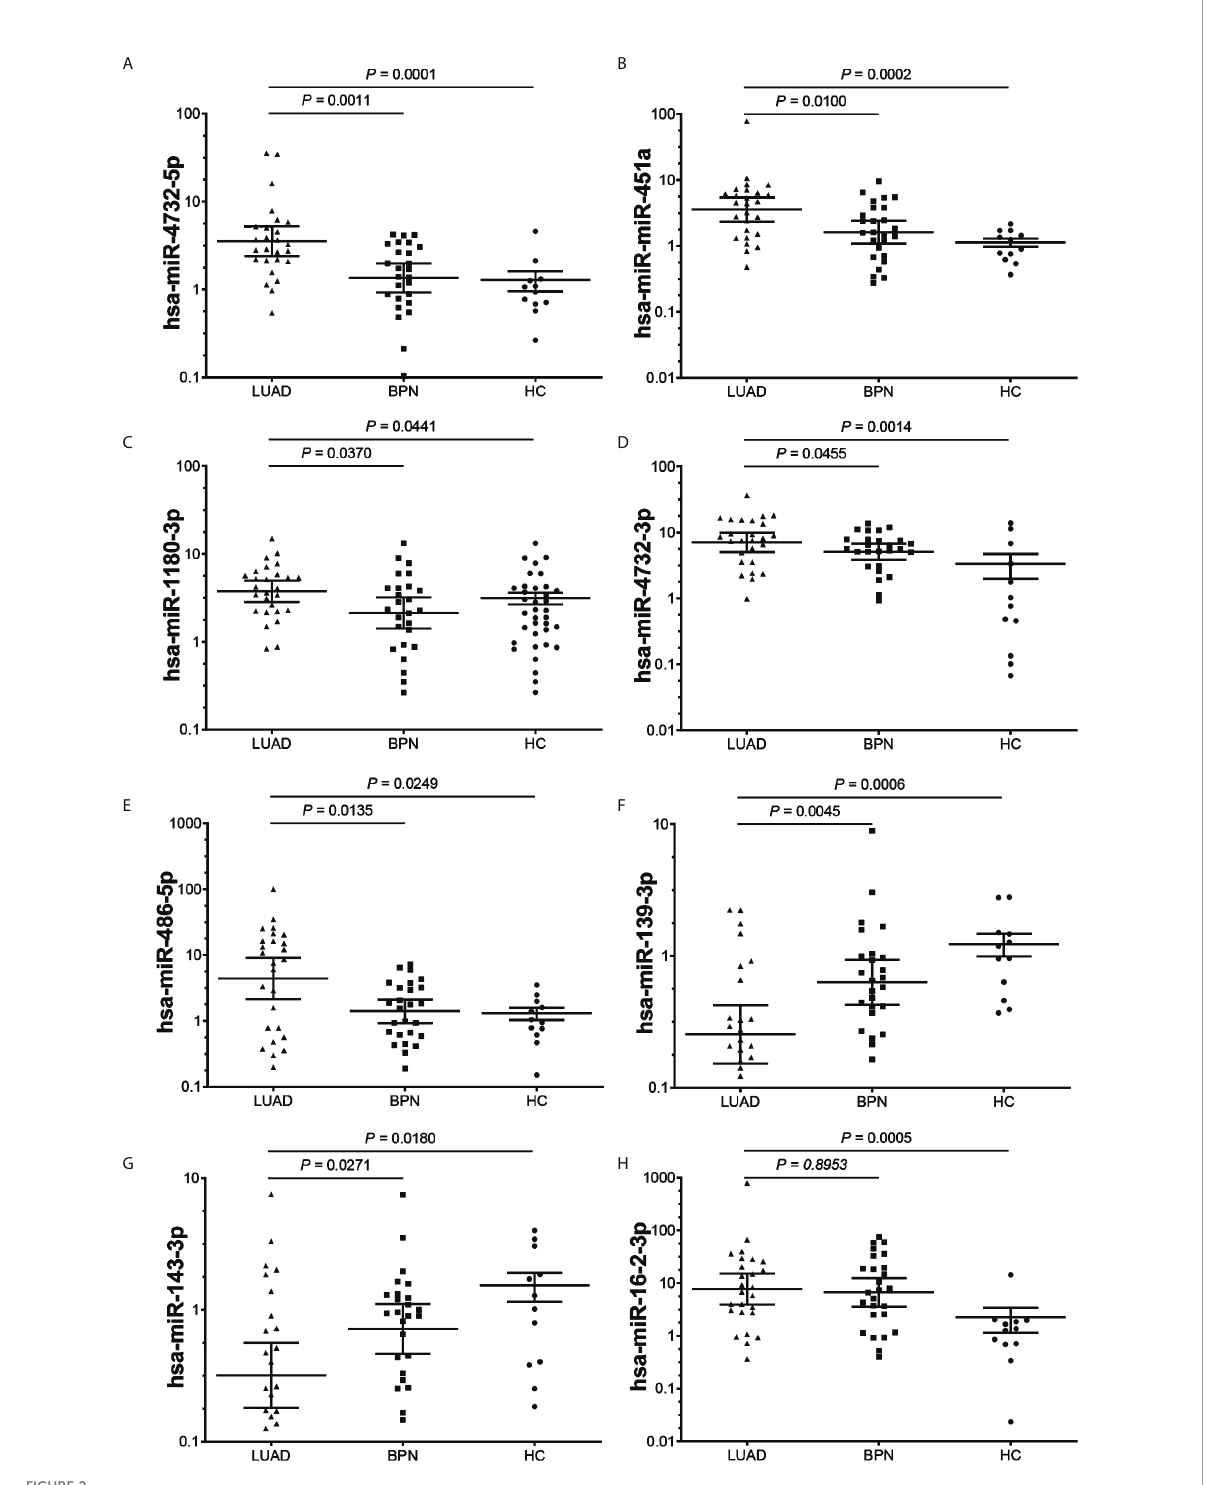
FIGURE 2 The expression levels of serum exosomal DEmiRs in the early LUAD, BPN and HC groups. (A – G) , The expression levels of 7 exosomal DEmiRs in LUAD group were signi fi cantly different from those in the BPN and HC groups. (H) , The DEmiRs was signi fi cantly up-regulated in LUAD group compared to that of HC group, whereas it did not show signi fi cant difference in LUAD group compared to BPN group. DEmiR, differentially expressed miRNA; LUAD, lung adenocarcinoma; BPN, benign pulmonary nodule; HC, healthy